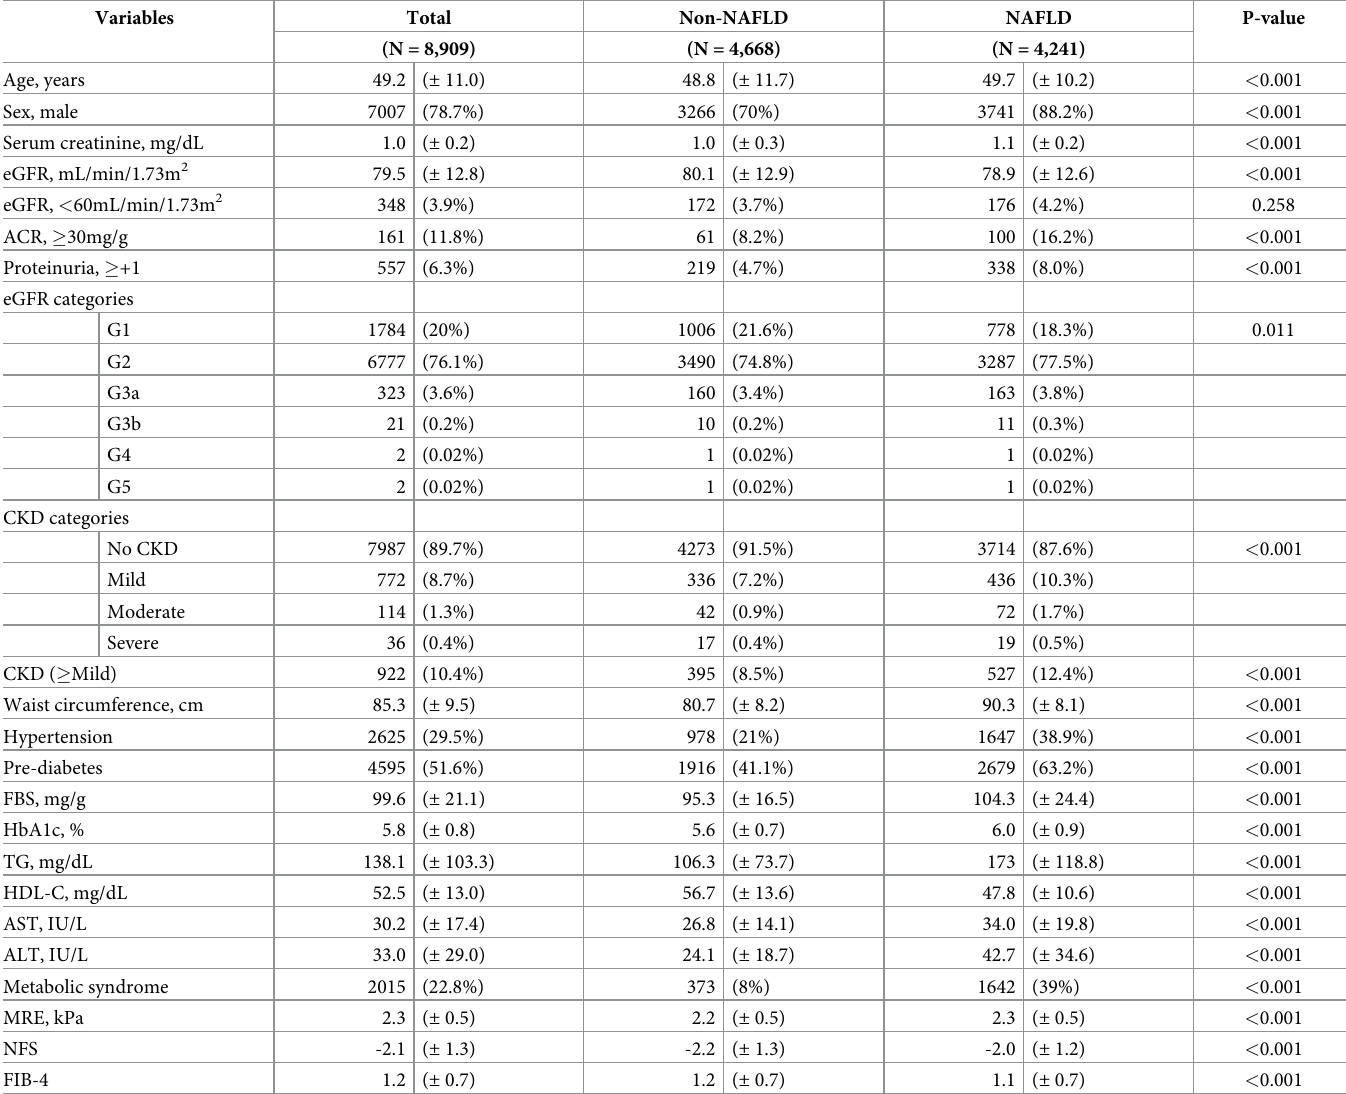
Table 1. Characteristics of study subjects with or without